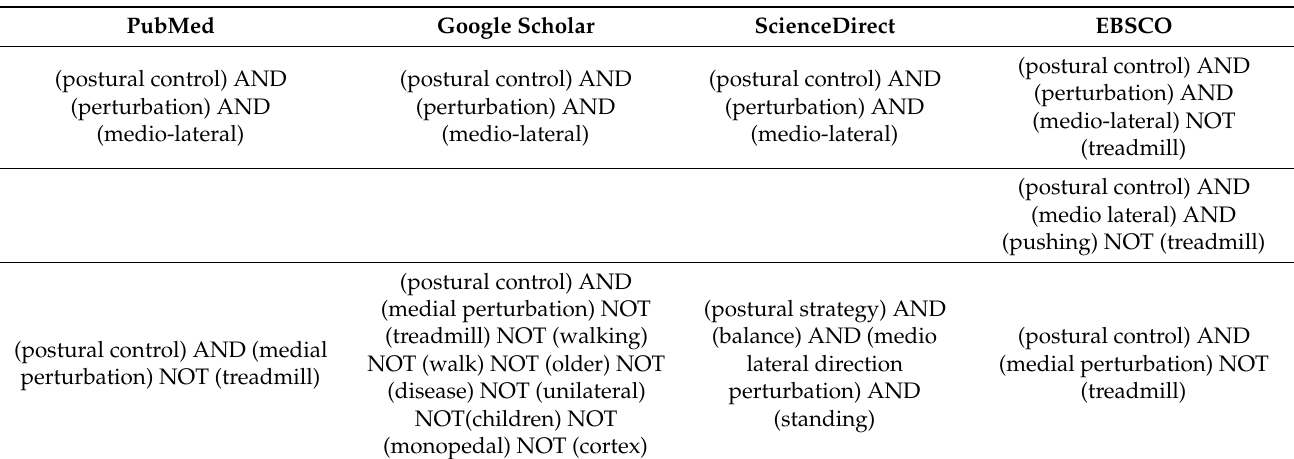
Table 1. The search term combinations applied within each of the four electronic